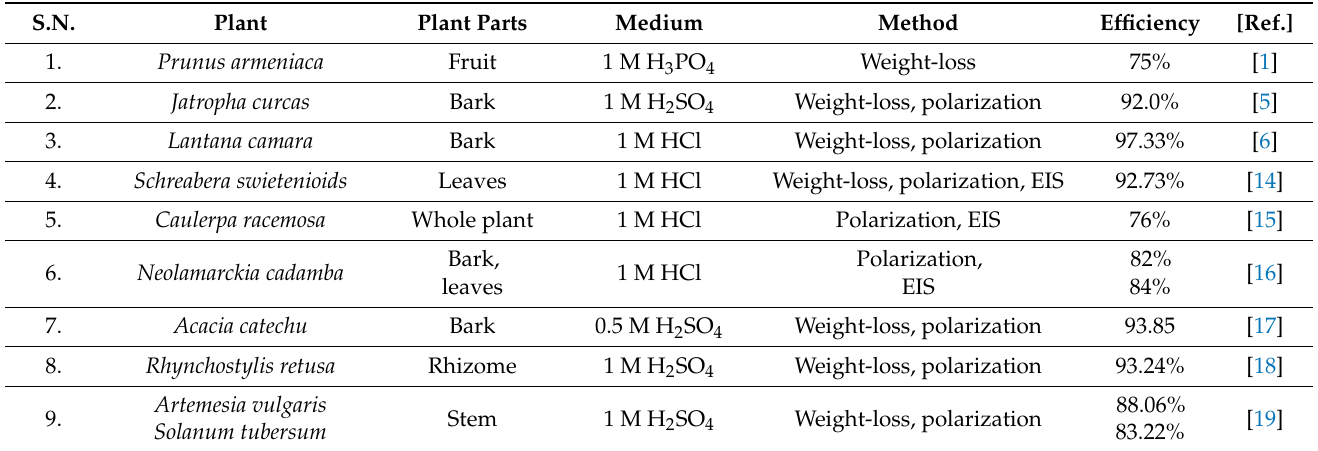
Table 1. Table showing a list of plants and the corrosion inhibition efficiency of their